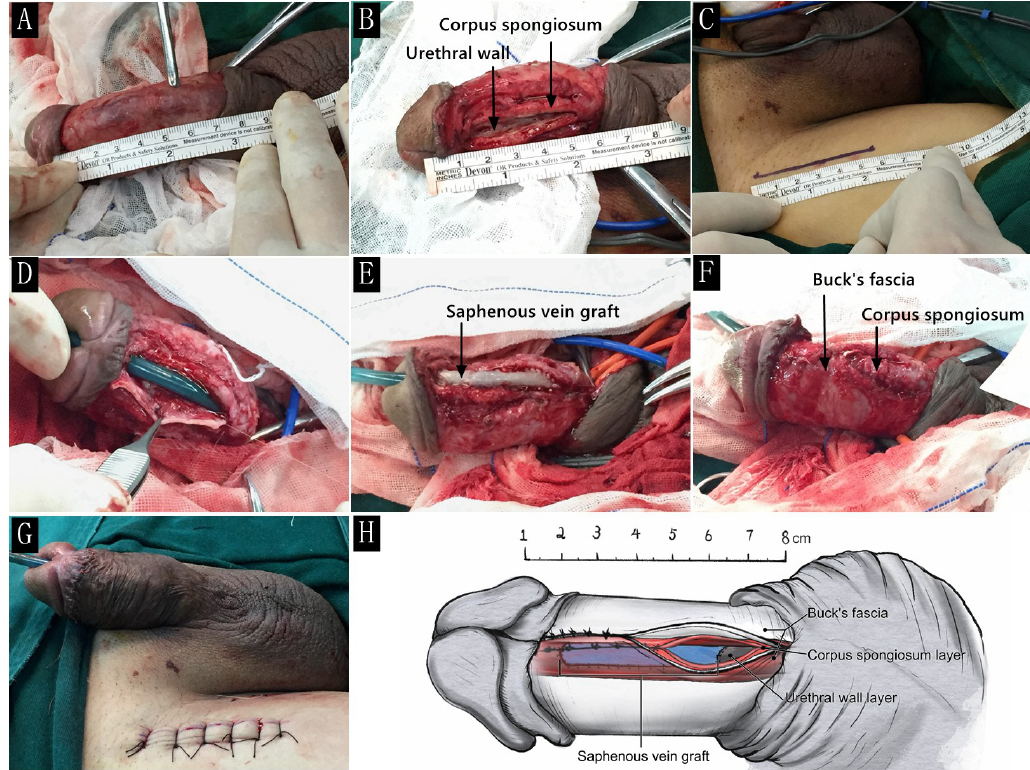
Fig. 1. Procedure for anatomic urethroplasty (AU) using everted saphenous vein graft (eSVG). (A) Expose the penile urethra, and measure the length of the segment of the urethral stricture (6-cm). (B) A longitudinal incision was made at Buck’s fascia, the corpus spongiosum, and the urethral wall until the urethral lumen was exposed. (C) Harvest a 6-cm long blood vessel (the saphenous vein) from the inner side of the right thigh. (D) An F16 hydrophilic catheter was inserted and the free edge of the eSVG was anastomosed with the free edge of the urethral wall using a 6–0 absorbable thread. (E,F) The free edge of the incised corpus spongiosum (E) and Buck’s fascia (F) was then re-anastomosed using a 4–0 absorbable thread. (G) The skin and superficial fascia layer were restored, and the incision was closed. (H) The hierarchy of the penile urethra in AU was displayed with an